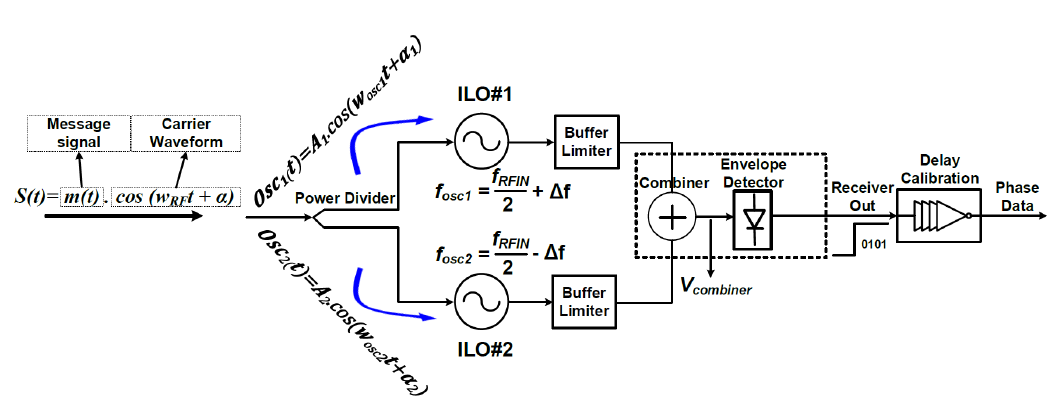
Figure 7. Operating principle of phase detection path.